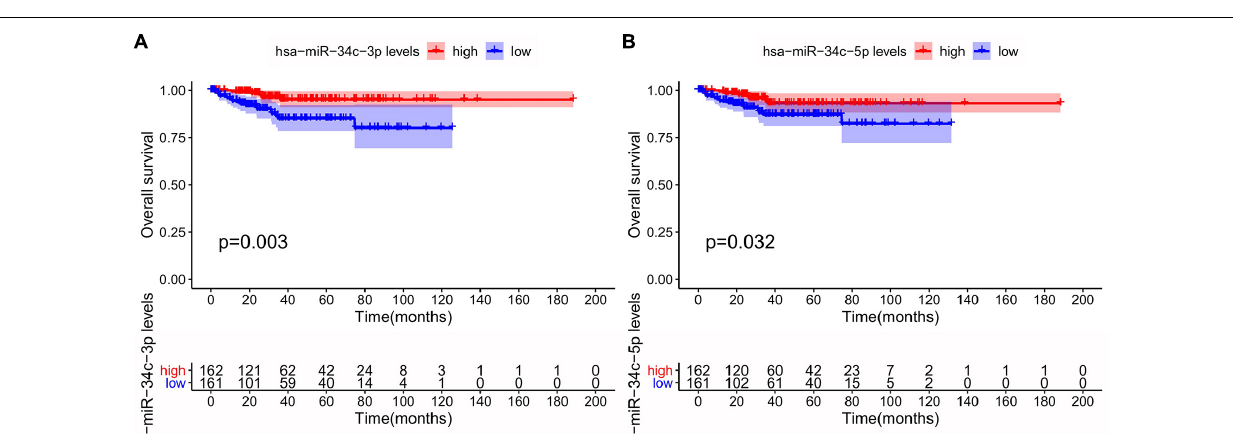
FIGURE 7 | Survival analysis of the miR-34c-3p (A) and miR-34c-5p (B) in The Cancer Genome Atlas (TCGA) database. This figure describes the survival analysis (Kaplan–Meier plot) of the miR-34c-3p and miR-34c-5p in endometrial endometrioid carcinoma (EEC) in TCGA database. The red line and blue line represented groups with higher expression and lower expression of specific miRNA,